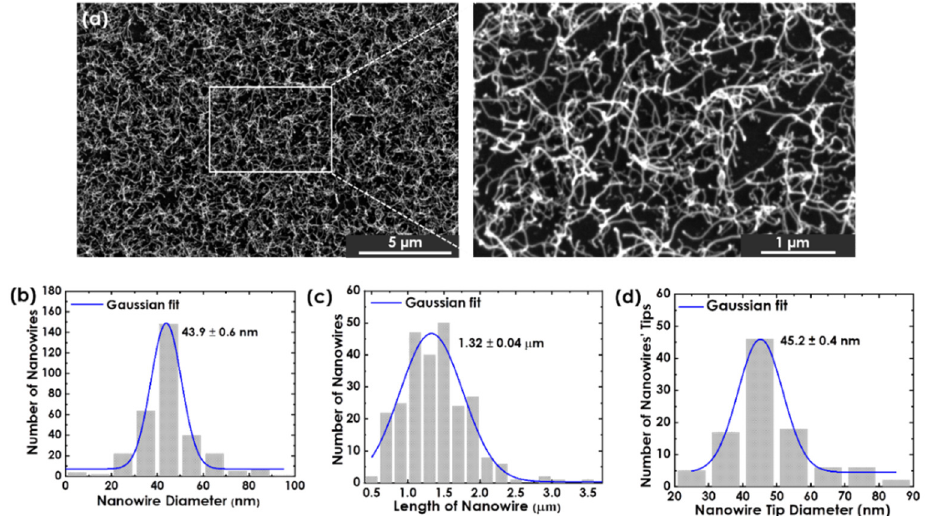
Figure 6. ( a ) SEM micrographs of GeTe nanowires, forest grown via the VLS method using 5.80 ± 0.10-nm Au nanoclusters with a yield of 0.10 ± 0.0 deposited for 1 h. Histogram of GeTe nanowires’ ( b ) average diameter and ( c ) length. ( d ) Histogram of the size of Au nanoclusters attached to synthesized GeTe nanowires as a result of the VLS method.